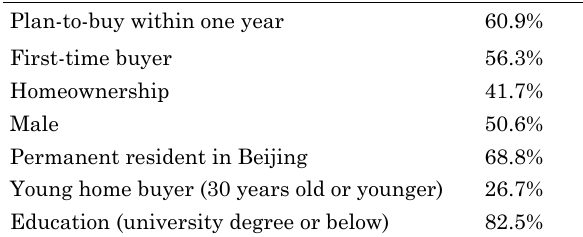
Table 1. Beijing housing market